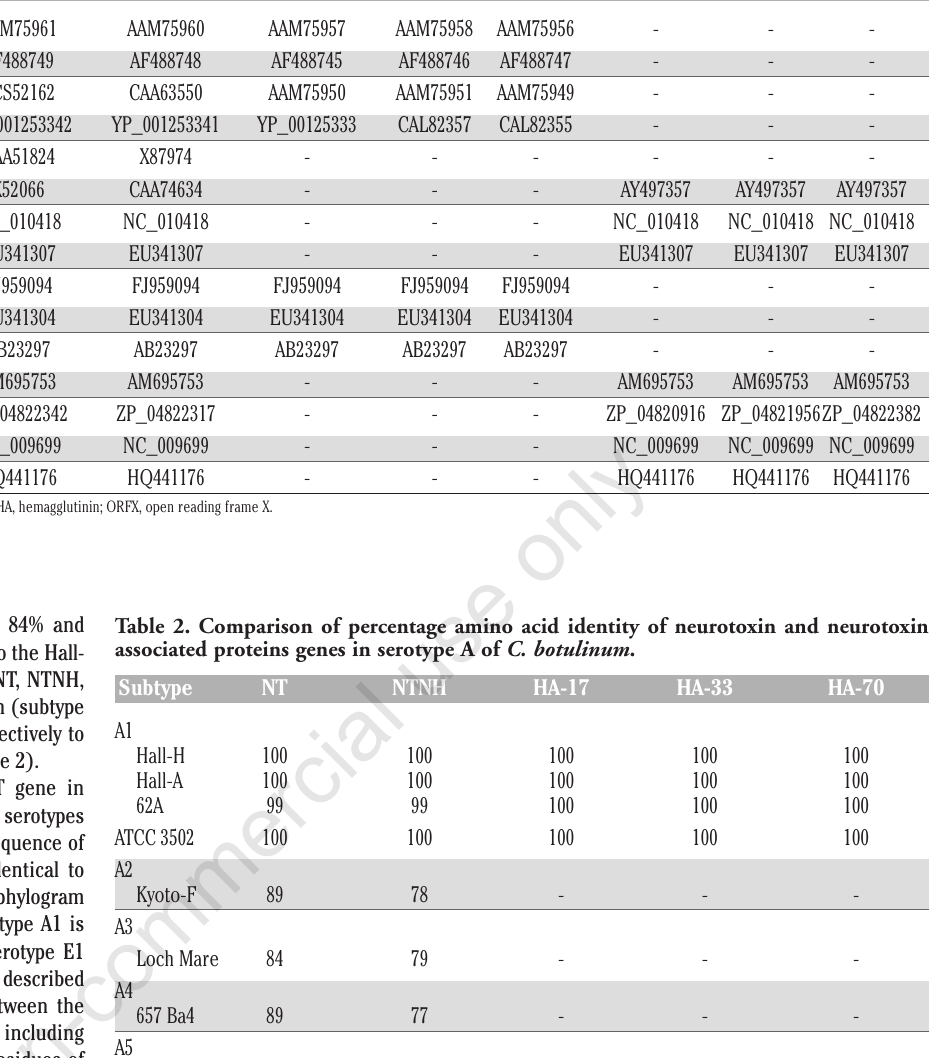
Table 1. Gene bank accession numbers of Clostridium botulinum strains used in sequence analyses. Gene bank accession numbers are from National Center for Biotechnology Information databases. Strain